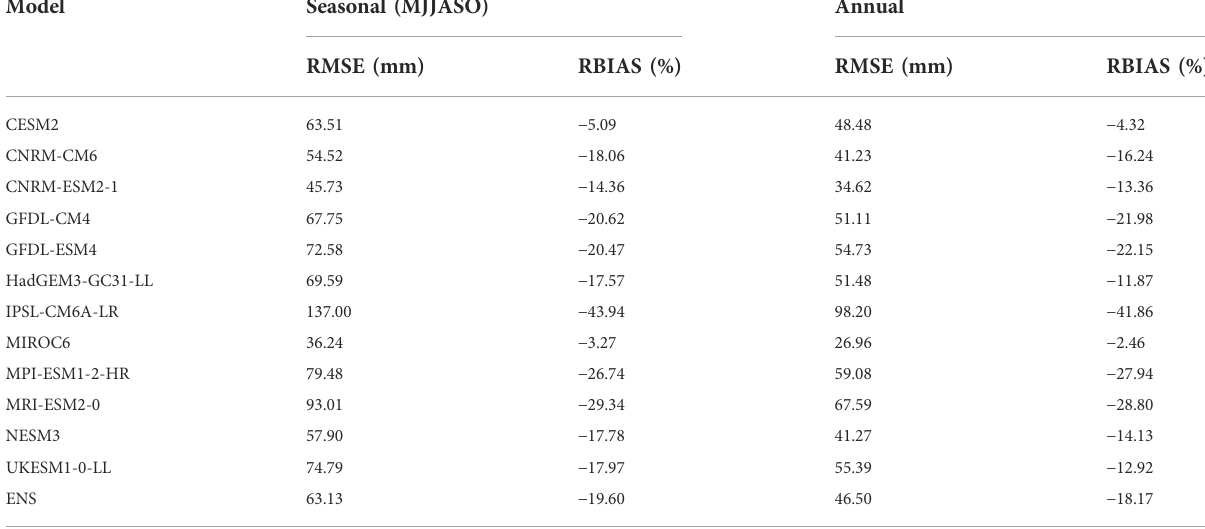
TABLE 2 Root mean square error (RMSE, mm) and relative bias (RBIAS, %) for seasonal (May – October, MJJASO) and annual precipitation in Myanmar during 1970 – 2014.